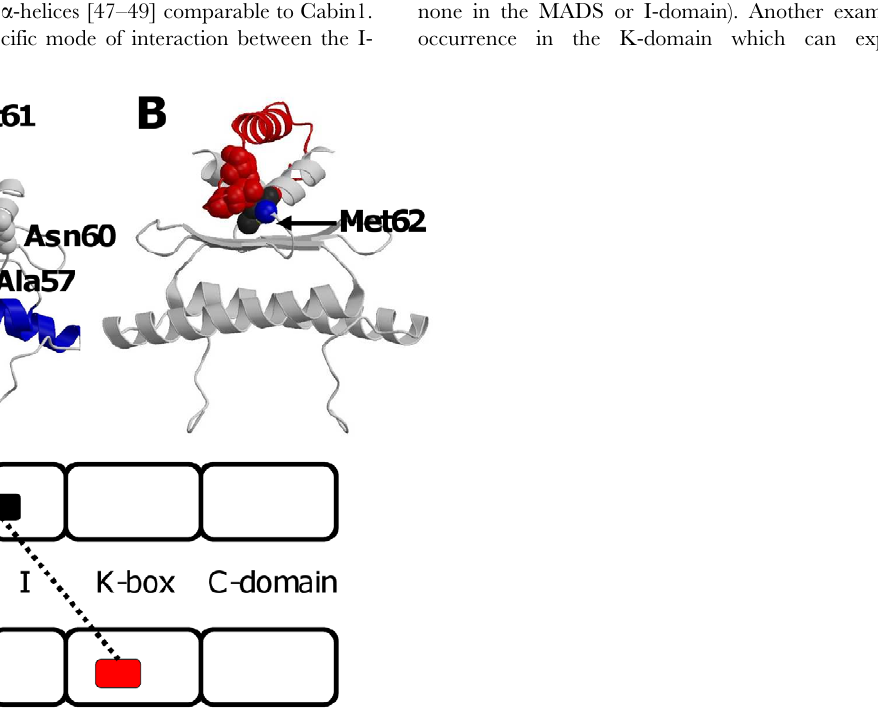
Figure 1. Combining predicted protein-protein interaction motifs and modeled protein structures. ( A ) Modeled dimer for the Arabidopsis MADS domain protein SUPPRESSOR OF OVEREXPRESSION OF CO 1 (SOC1). Blue indicates the DNA binding helix (in which no protein-protein interaction motifs are present). Residues indicated in spacefill (Ala57, Asn60 and Met61) are part of an experimentally validated interaction motif in the so-called ‘hotspot region’ (see text for details). ( B ) Crystal structure (PDB 1n6j) of human MADS domain protein MEF2 (grey) in complex with Cabin1 (red). Cabin1 contacts MEF2 via Met62 and a few other amino acid residues. MEF2 Met62 is the equivalent of Met61 in SOC1, with both amino acid residues having comparable positions in the structure. The residues of Cabin1 that contact Met62 (Ser101, Gly104 and Ile106) are shown in red spacefill. Based on the MEF2-Cabin1 structure we hypothesize a similar kind of binding of the a -helix-forming K-box from a SOC1 interacting MADS domain protein on top of the SOC1 MADS/I domain. ( C ) The black box indicates the predicted interaction motif in the ‘hotspot region’ of the SOC1 protein. The predicted complementary interaction motif (red box) is located in the K-box domain of the MADS domain protein interacting with SOC1.